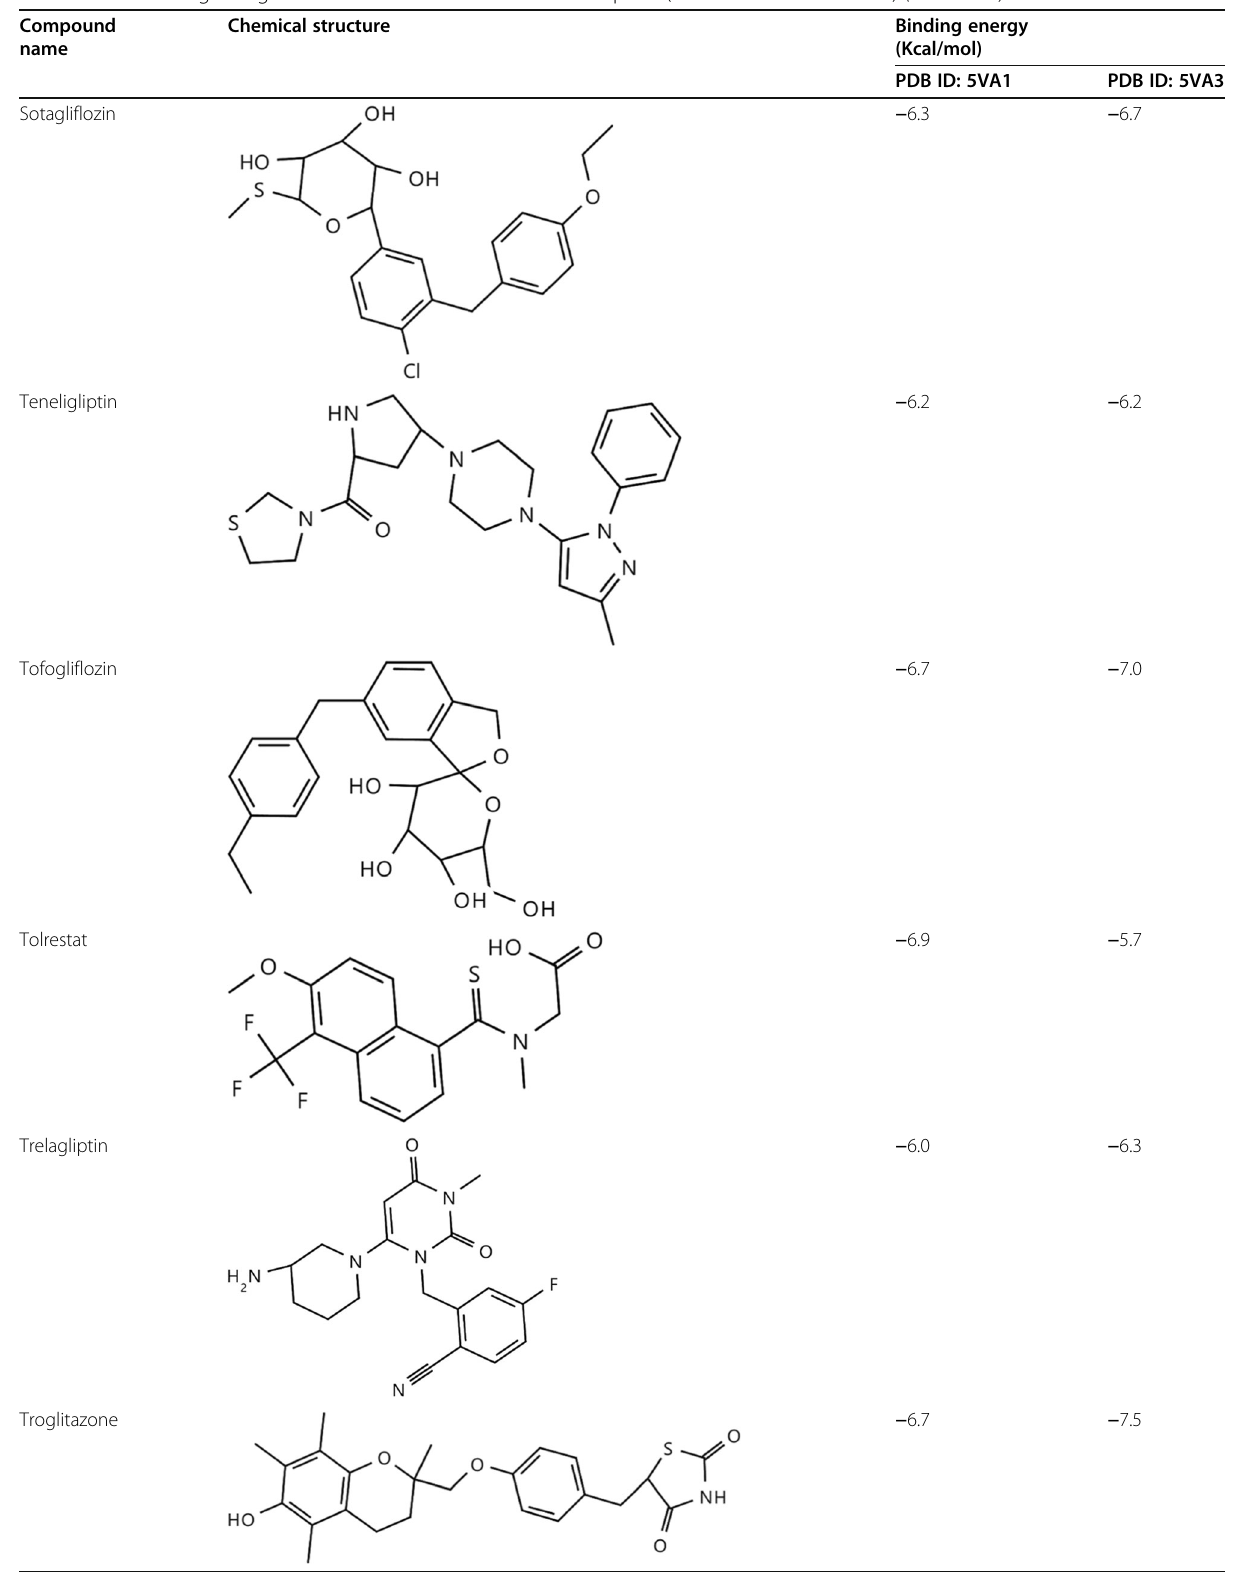
Table 2 The binding energies of the inhibitors with the two receptors (PDB IDs: 5VA1 and 5VA3)